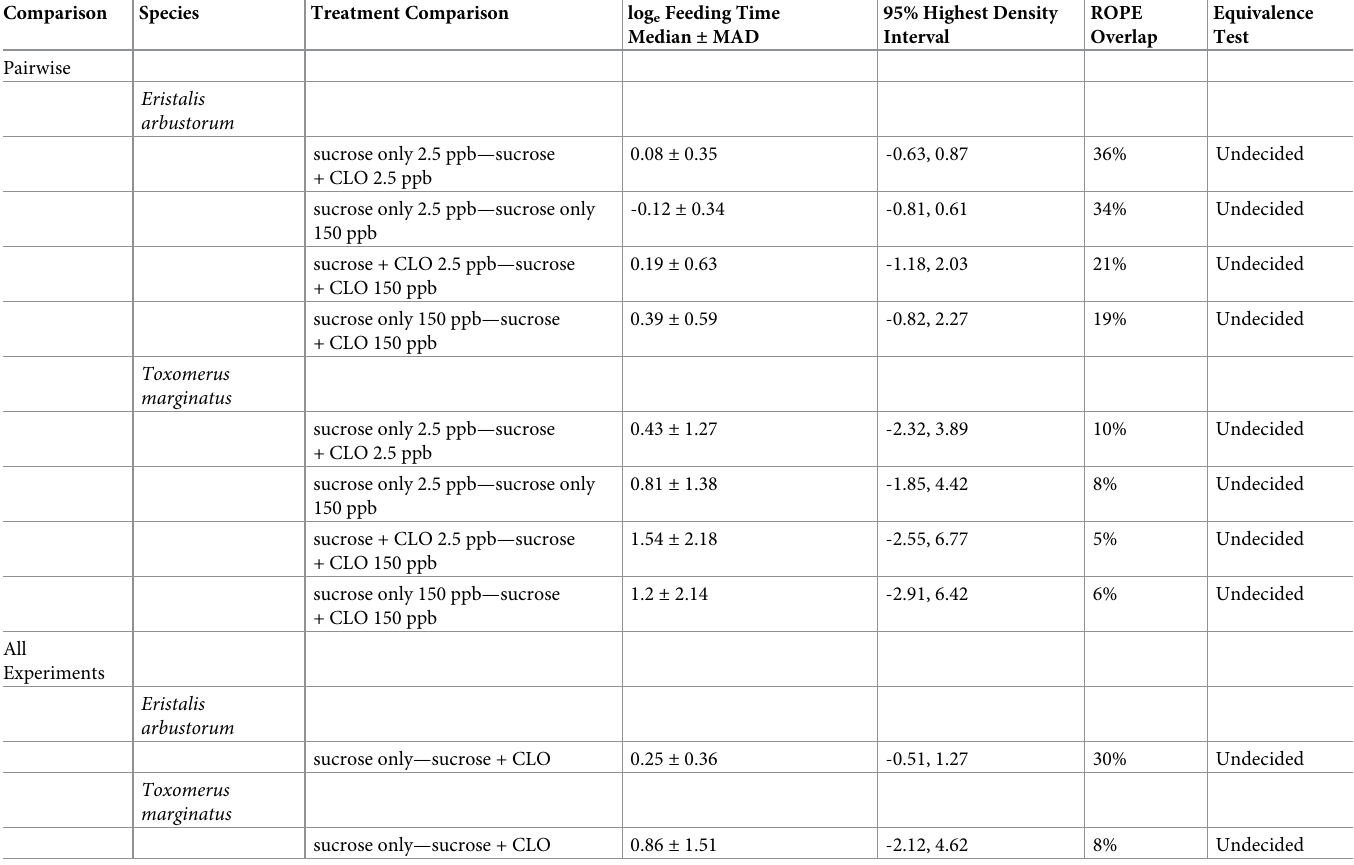
Table 1. Hover fly feeding response time differences (log e ) between two-choice experimental treatments and across all experimental treatments.